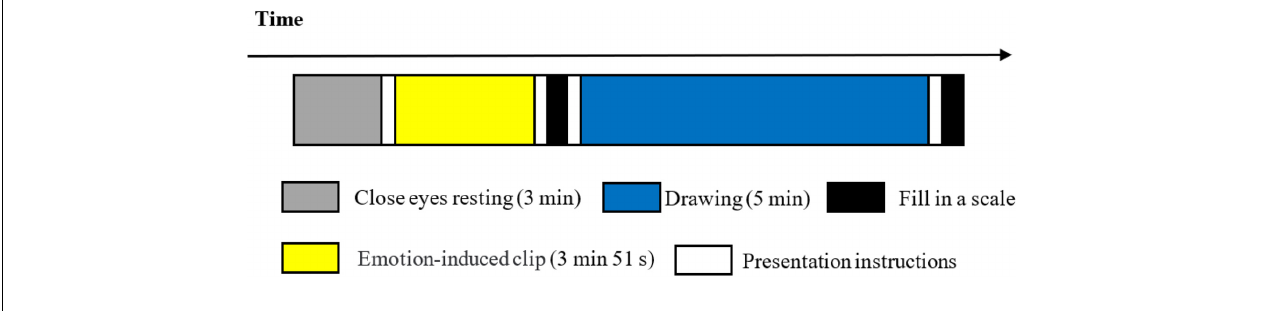
FIGURE 2 | Experimental procedure.